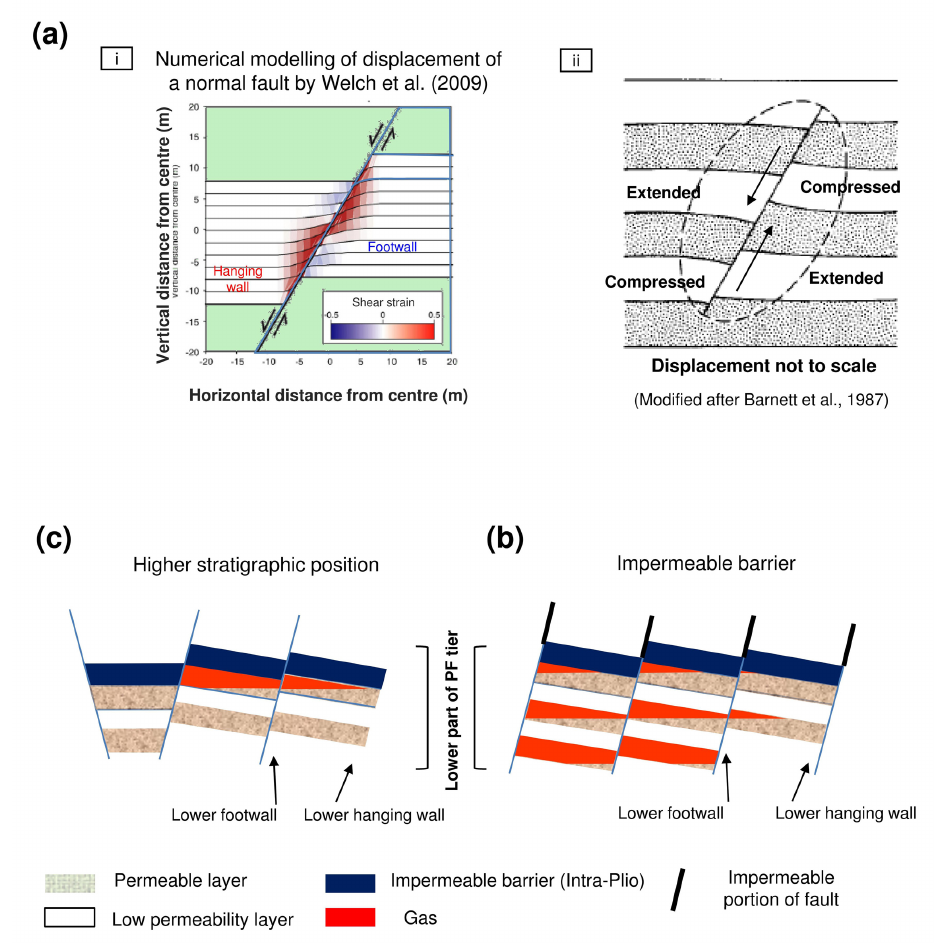
Figure 15. Causes of gas retention within the lower part of PF blocks. (a) Stress distribution around a normal fault. (i) Magnitude of shear strain around a normal fault (modified after Welch et al, 2009). (ii) Displacement of horizontal beds by a normal fault and regions of relative extension and compression in the vicinity of a normal fault in shallow unlithified sediments (modified after Barnett et al., 1987). (b) A higher stratigraphic position of permeable layers in PF footwalls (compared to hanging wall) leads to preferential gas accumulation in such locations. (c) A sufficiently impermeable barrier in the middle of the PF tier prevents further upward migration of free